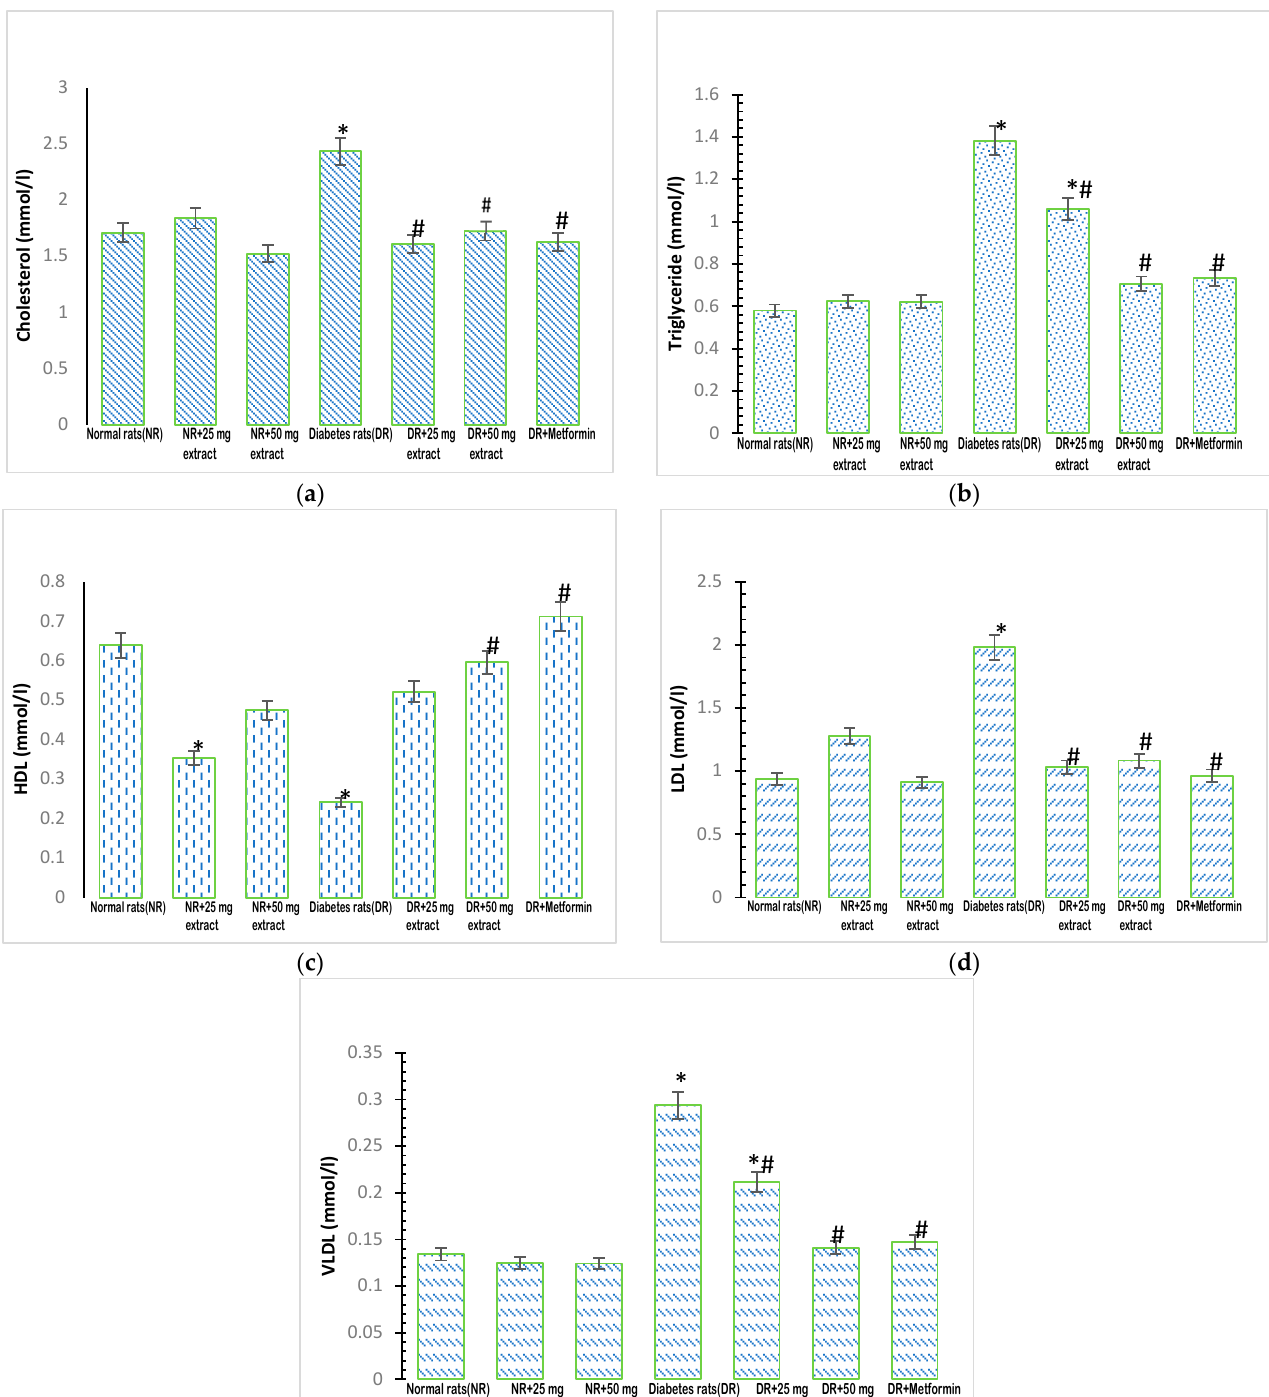
Figure 1. Lipid profile of rats treated with FFMTSE. ( a ) Concentration of cholesterol, ( b ) triglycerides, ( c ) HDL-Cholesterol, ( d ) LDL cholesterol, and ( e ) VLDL cholesterol in rats treated with FFMTSE. All results are expressed as mean ± SD. (*) indicates a significant difference compared to the normal control group at p < 0.05, and (#) indicates a significant difference compared to the diabetic control group at p < 0.05. FFMTSE- Flavonoid-rich fraction of Monodora tenuifolia seed